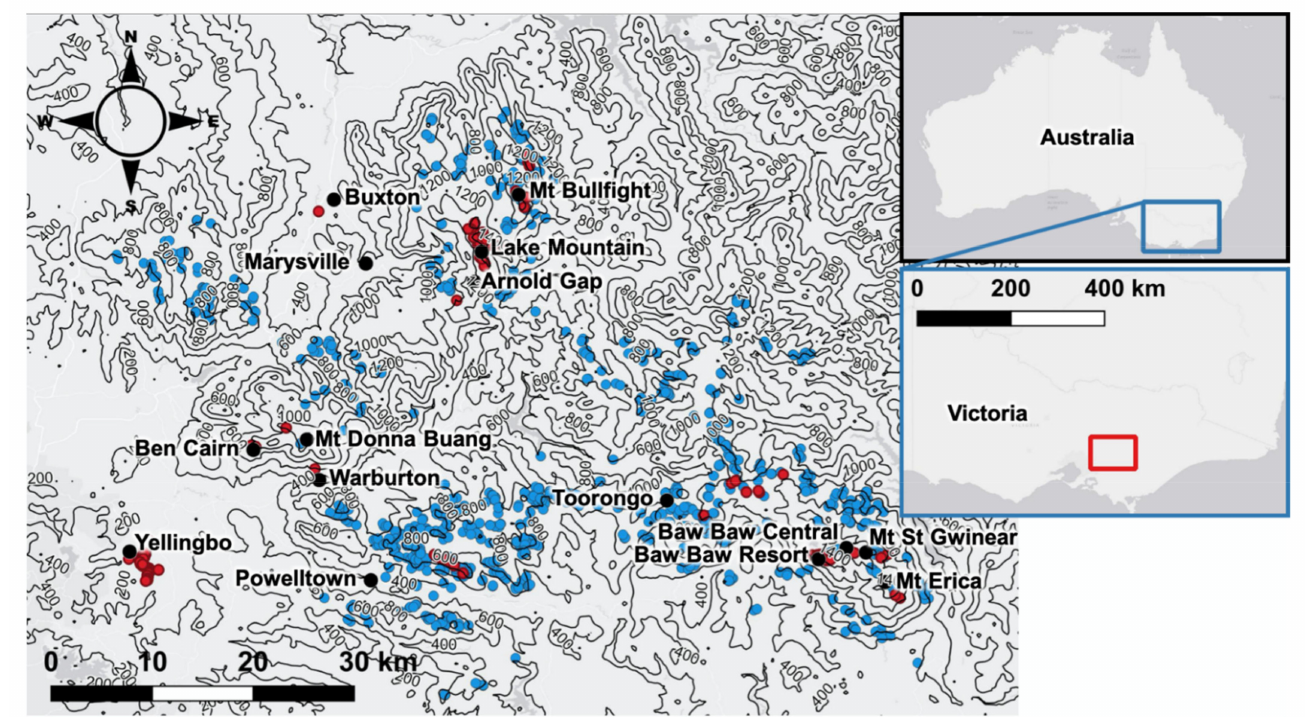
Figure 1. Map of sampling locations for genetic samples used in this study (red dots). The blue dots are observations of the species from 2010–2020, indicating the contemporary range. The extent of the sampling area is indicated by the red rectangle on the inset. Contour lines indicate elevation above sea level in